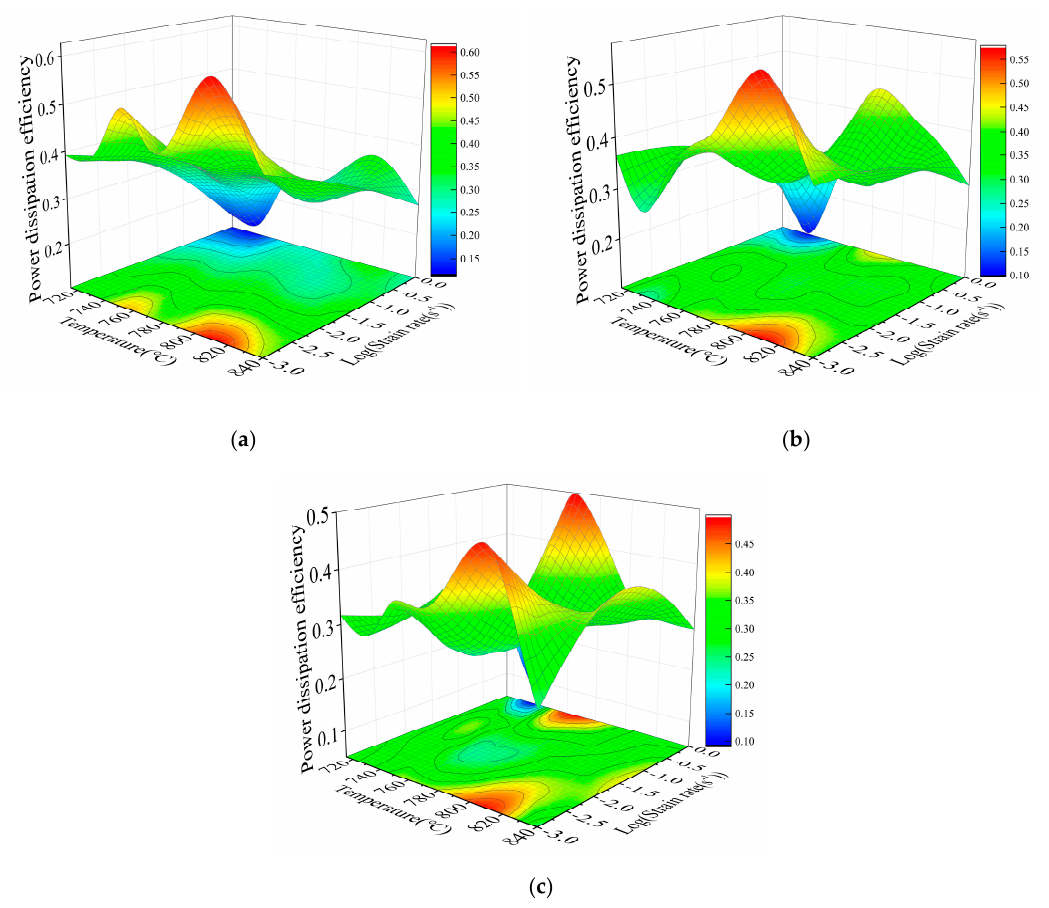
Figure 8. The power dissipation map of Ti-6554 alloy at the true strain of: ( a ) 0.3; ( b ) 0.6; ( c ) 0.9.